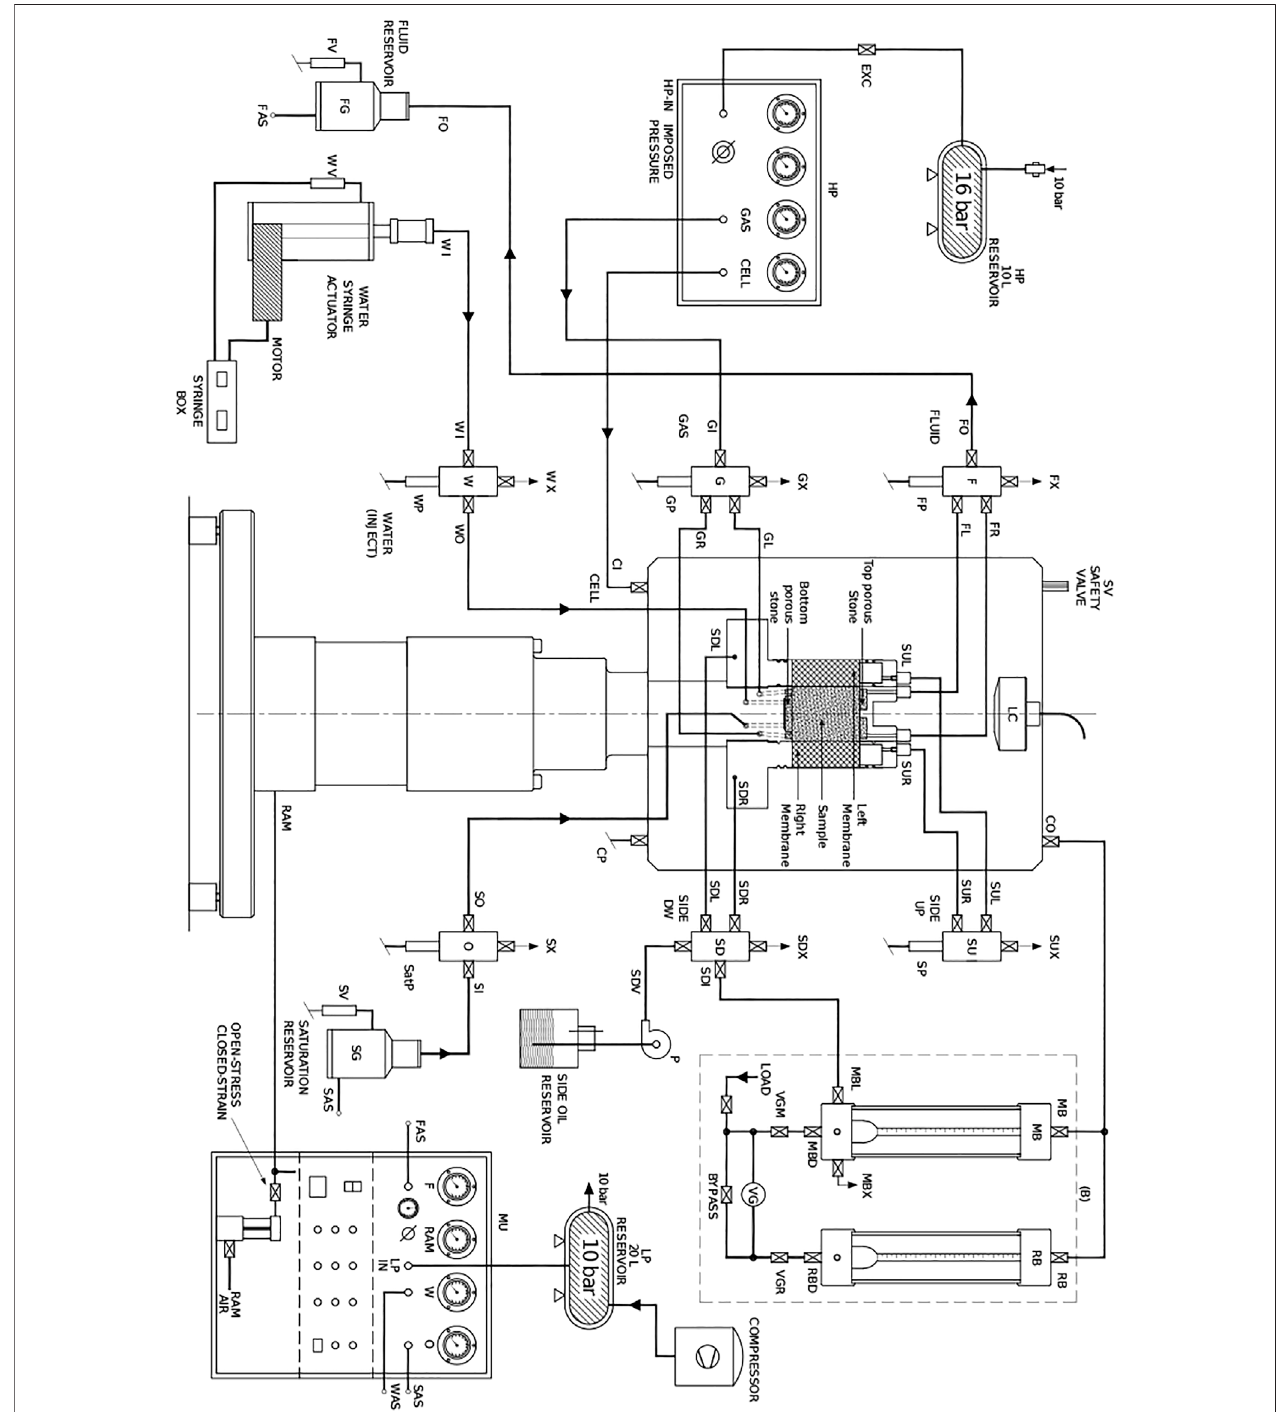
FIGURE 2 | Biax block schematics provided by Megaris,